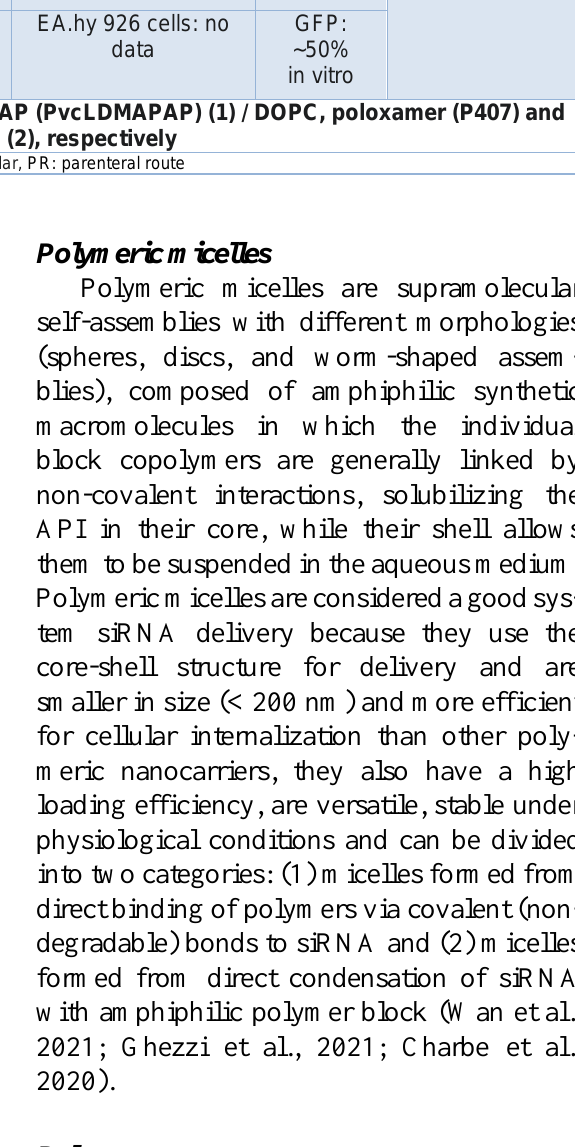
Table 1 (cont.): Nanocarriers composed of lipid nanoparticles Nanocarrier/ Route a goal Components: DOPC, Chol, and PEI- stearic acid Liposome /